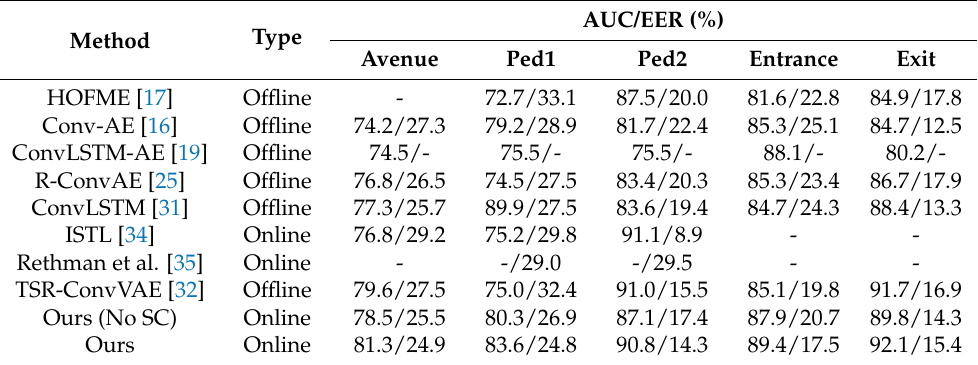
Table 1. Comparison of existing methods on frame level (AUC and EER). (No SC: indicates the removal of spatial constraints).